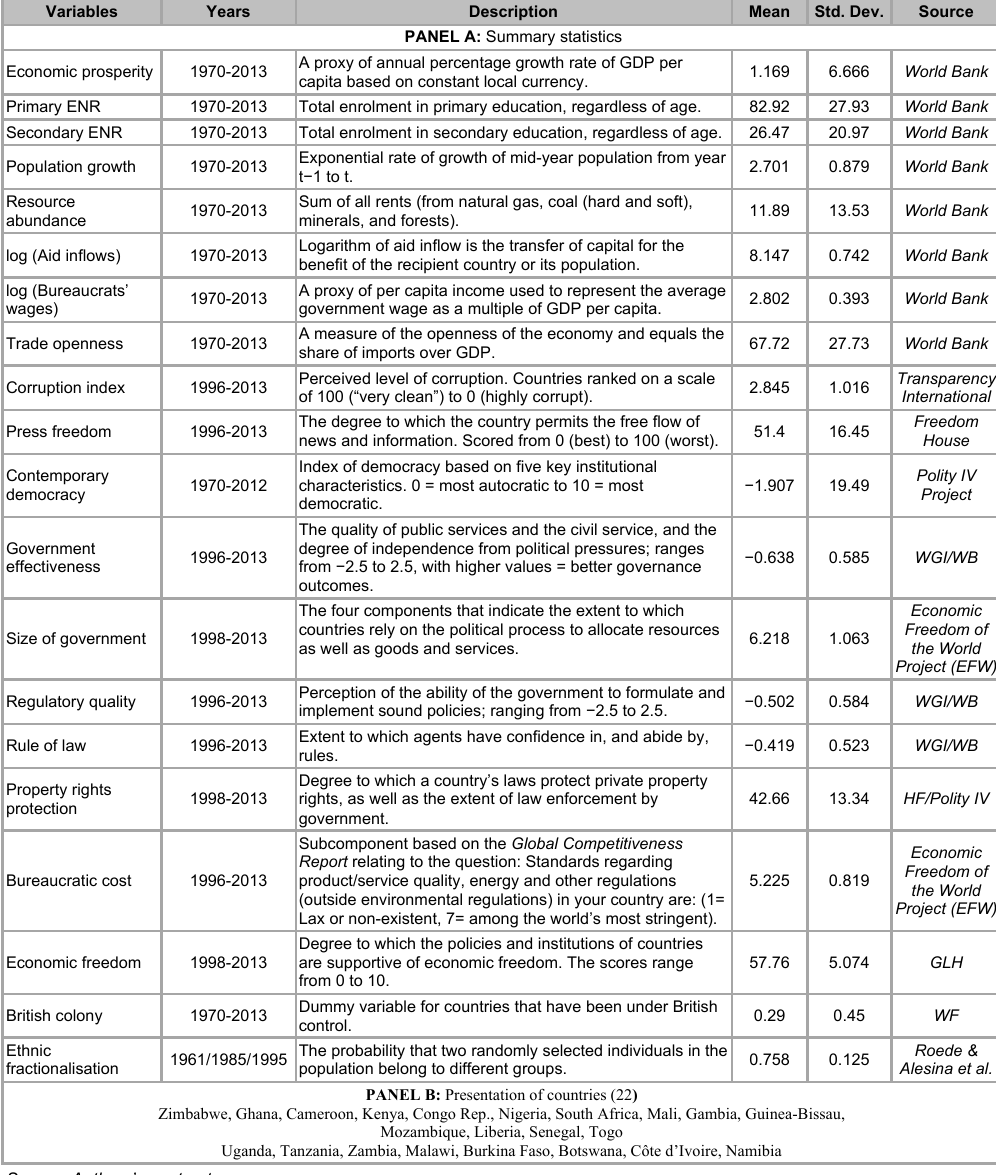
Data description and presentation of